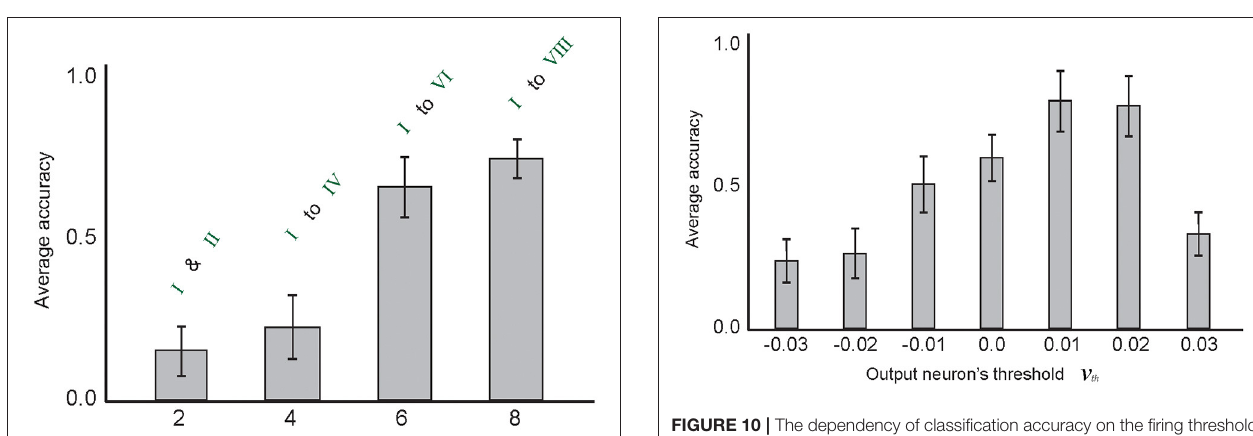
FIGURE 10 | The dependency of classification accuracy on the firing threshold of the output neuron. Average classification accuracy was measured for different firing threshold values from − 0.03 to 0.03, by training the network with 10 selected samples per digit class and testing on the entire test dataset. The results show maximum classification accuracy for the firing threshold set to 0.01. In these experiments, α and β values were set as 0.2 and 0.6, respectively. The µ value set to 0.8 and the connectivity rate between the second and third layer was set to 0.2.